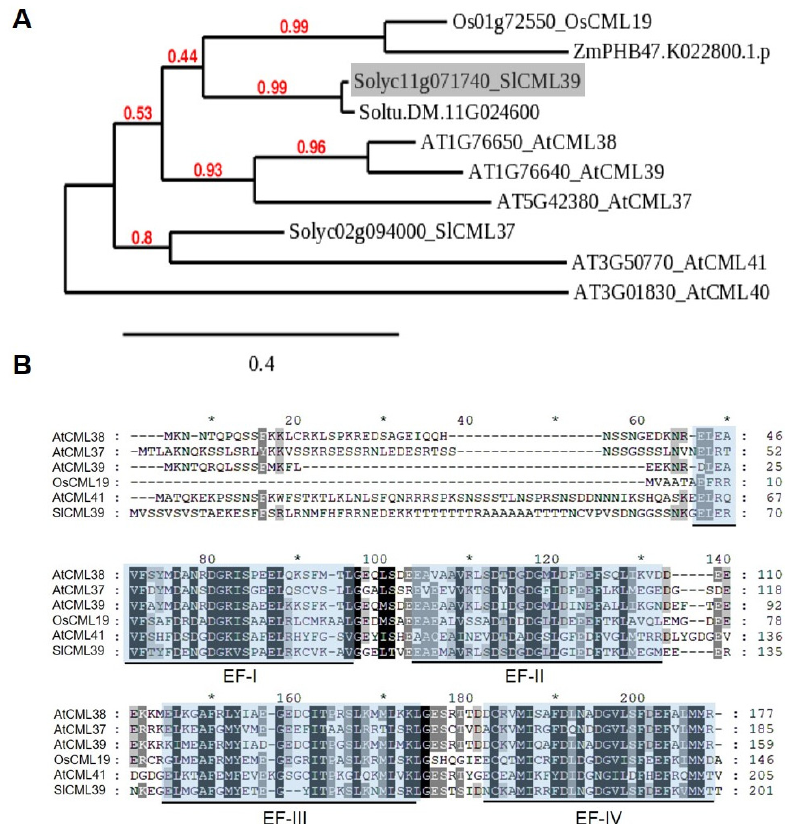
Figure 3. Phylogenetic tree and multiple sequence alignment of SlCML39 and its closely related CML proteins from other plant species. ( A ) The phylogenetic tree was constructed using MUSCLE/PhyML programs. The following protein sequences are included in the analysis: Arabidopsis (AT5G42380, AtCML37; AT1G76650, AtCML38; AT1G76640, AtCML39; AT3G01830, AtCML40; AT3G50770, AtCML41); Oryza sativa (Os01G72550, OsCML19); Zea mays (ZmPHB47.K022800.1.p); Solanum lycopersicum (Solyc11g071740, SlCML39); Solanum tuberosum (Soltu.DM.11G024600). SlCML39 is marked in gray. ( B ) Multiple sequence alignment of SlCML39 sequence with homologous CMLs from Arabidopsis and rice. Sequences were aligned by MUSCLE and shown by GeneDoc software. The EF hand motifs are underlined and the highly conserved amino acids in EF hand motifs are highlighted by the blue color.